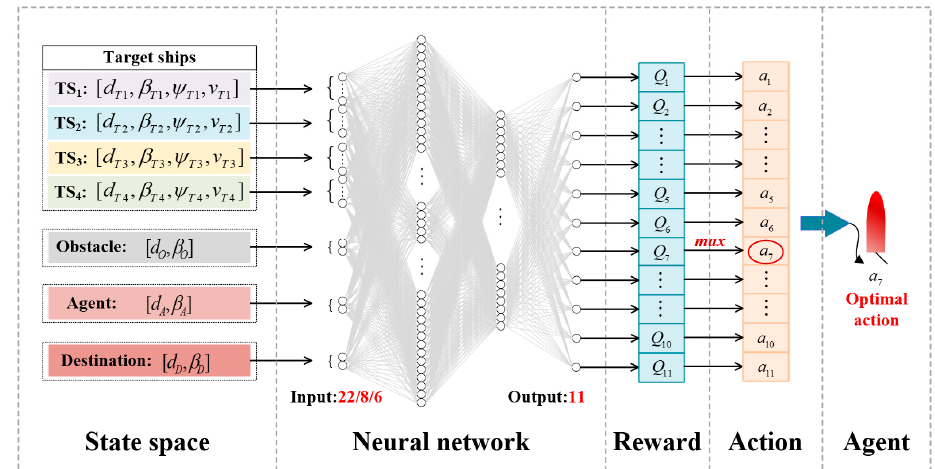
Figure 5. The action selection process of the agent.